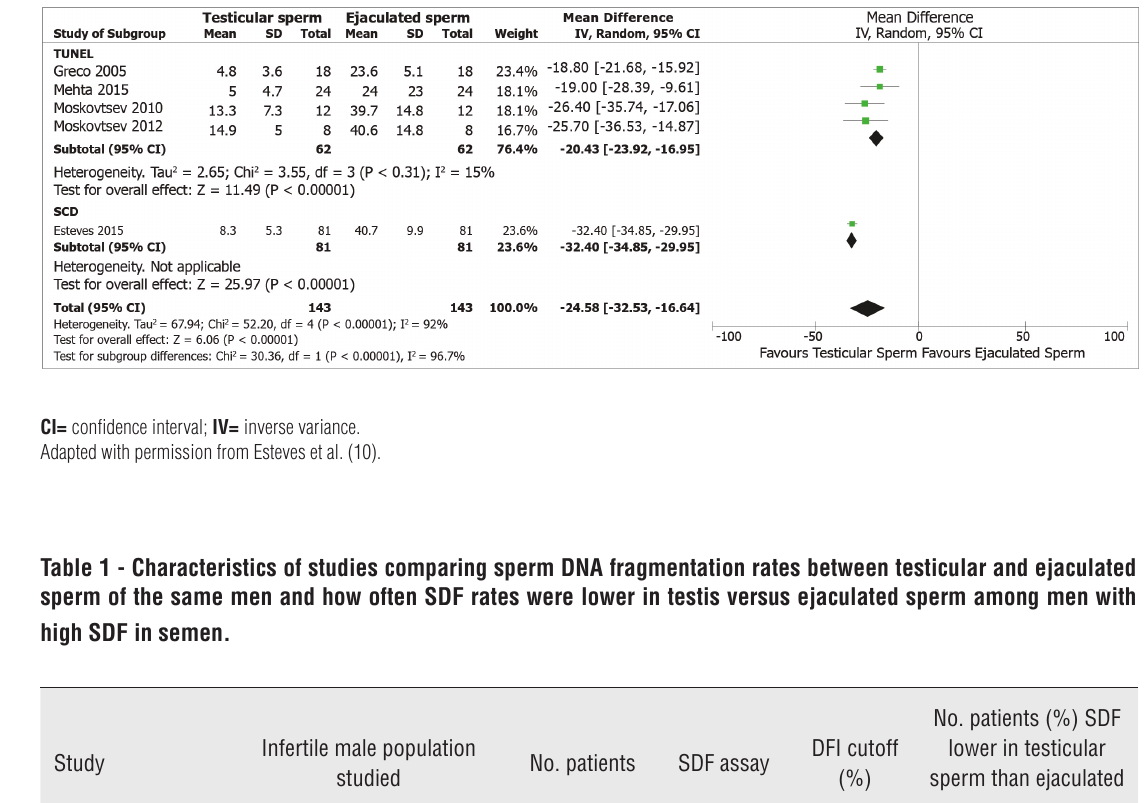
figure 2 - forest plot showing mean difference for sperm DNA fragmentation (SDf) rates between testicular and ejaculated sperm in men with high SDf, including subgroup analysis according to SDf assay (terminal deoxynucleotidyl transferase dUTp nick end labeling (TUNEL) and sperm chromatin dispersion (ScD)).